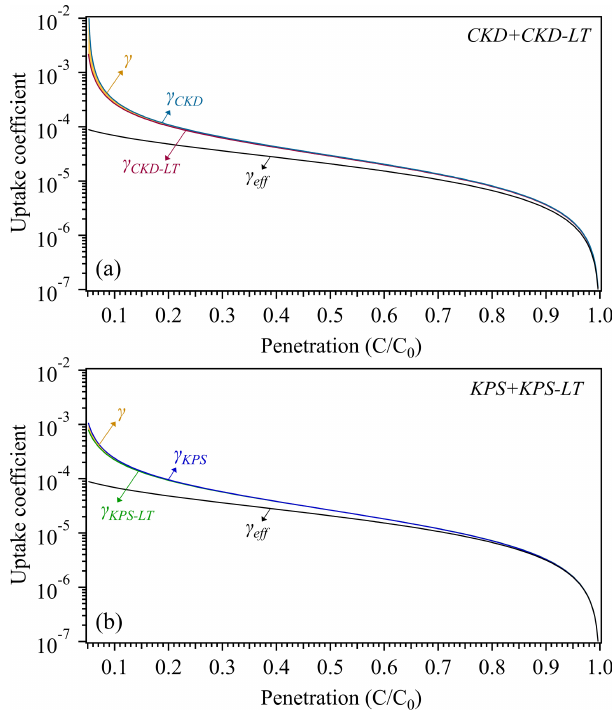
Figure 8. Schematic of different types of uptake coefficients versus the measured penetration ( C /C 0 ), using both diffusion correction methods CKD (a) and KPS (b) as well as their modified versions, i.e., CKD-LT and KPS-LT, to evaluate roughness-induced local tur- bulence effects. The yellow shaded area shows the uncertainty range of γ . Derivation of the uptake coefficient is based on the specific ex- perimental parameters in our previous study (Li et al., 2016): gas re- actant, HCHO; carrier gas, N 2 ; volumetric flow rate F = 1Lmin − 1 at 1atm and 296K; flow tube dimension, d = 7mm, L = 250mm. The δ g and δ r of the soil coating are estimated using scanning elec- tron microscopy: δ g /R 0 = 0.15, δ r /δ g =